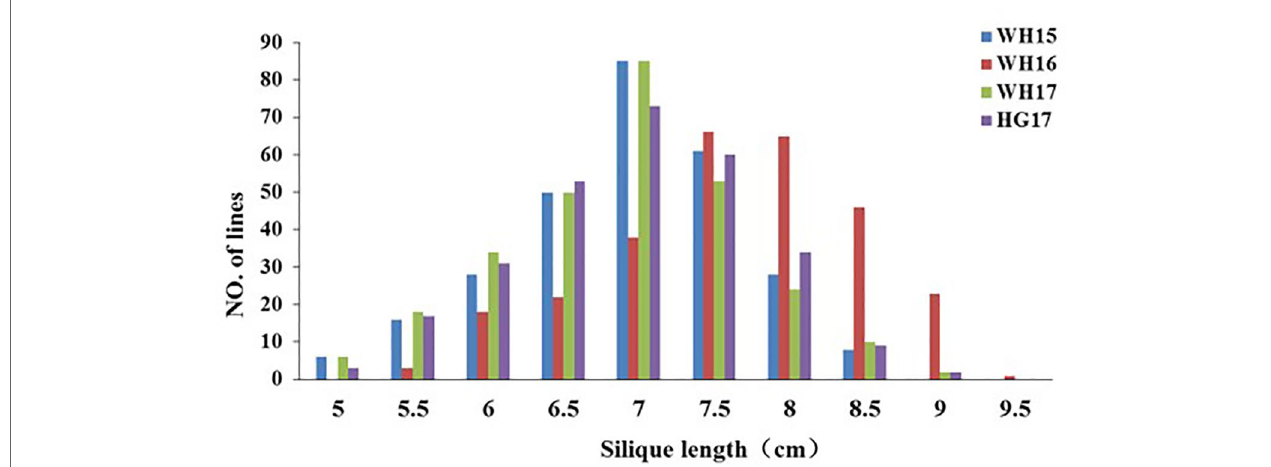
FIGURe 1 | Distribution of silique length in the ZR population derived from the cross Zhongshuang 11 × R11. WH15, WH16, WH17, and HG17 represent four environments with different colors . WH15: Wuhan, 2014–15; WH16, Wuhan, 2015–16; WH17, Wuhan, 2016–17; and HG17, Huanggang, 2016–17.